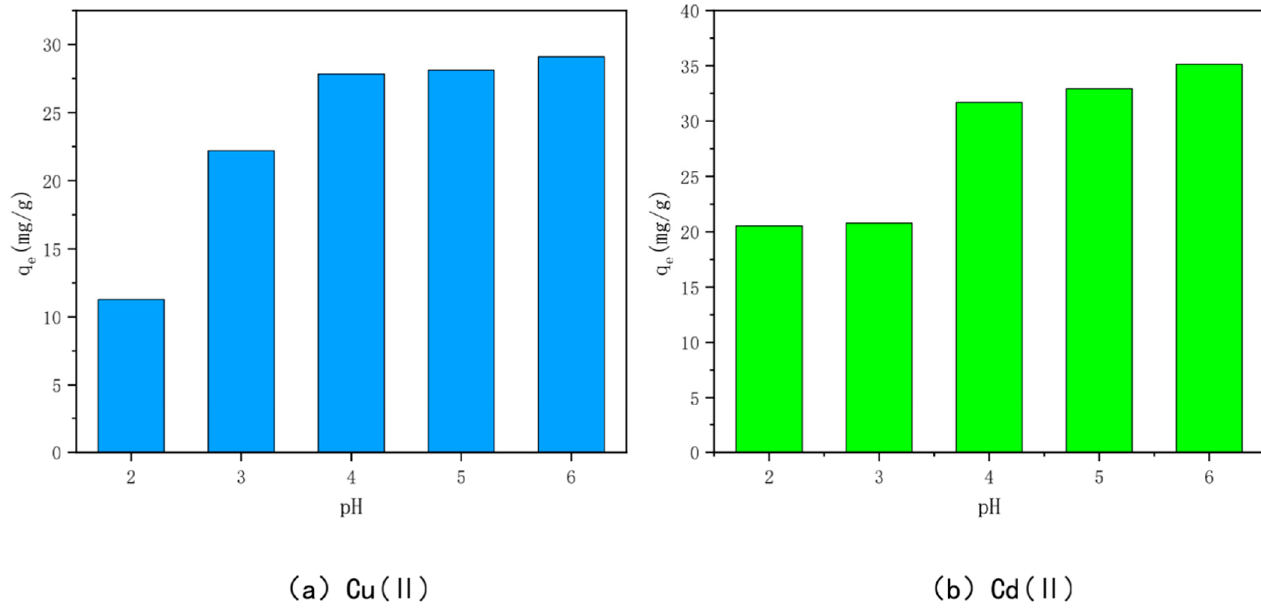
Figure 9. Effect of pH on the adsorption of Cu(II)/Cd(II) by